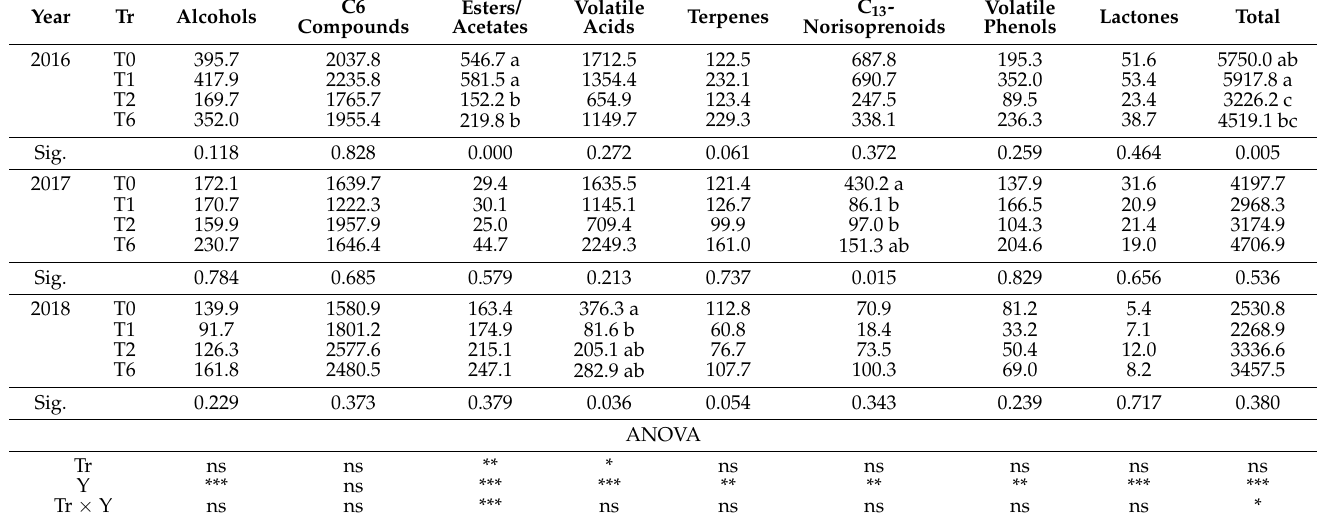
Table 4. Total volatile compound concentrations ( µ g L − 1 ), grouped by chemical families in Albariño musts under different water status treatments over three